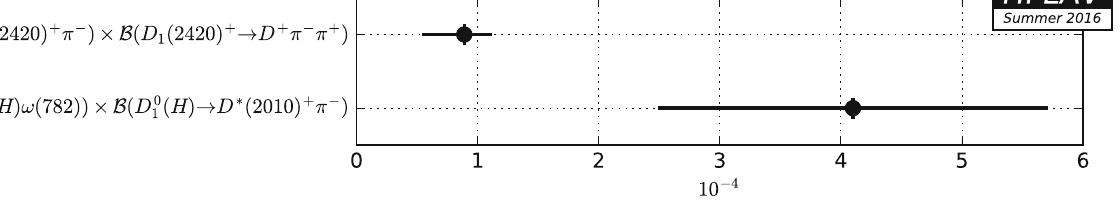
Fig. 76 Summary of the averages from Table